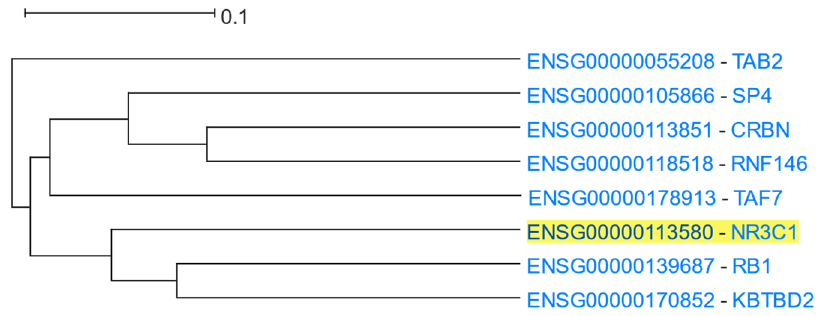
Figure 13. HGCA2.0 NR3C1 3 internal node coexpression